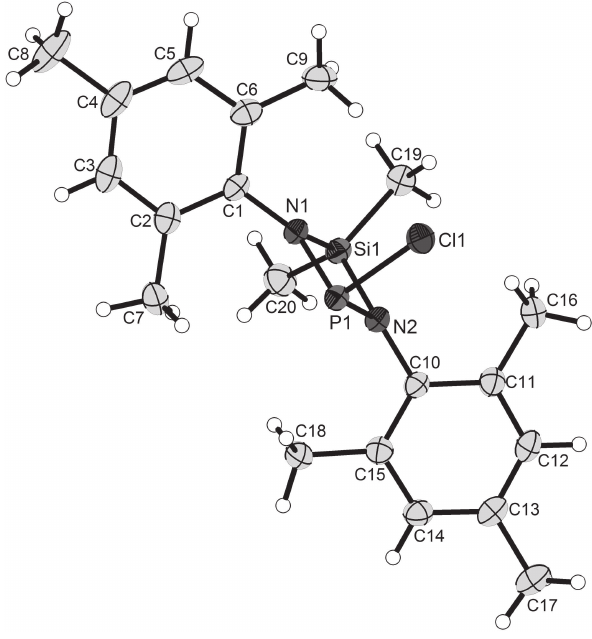
Table 1: Data collection and handling.